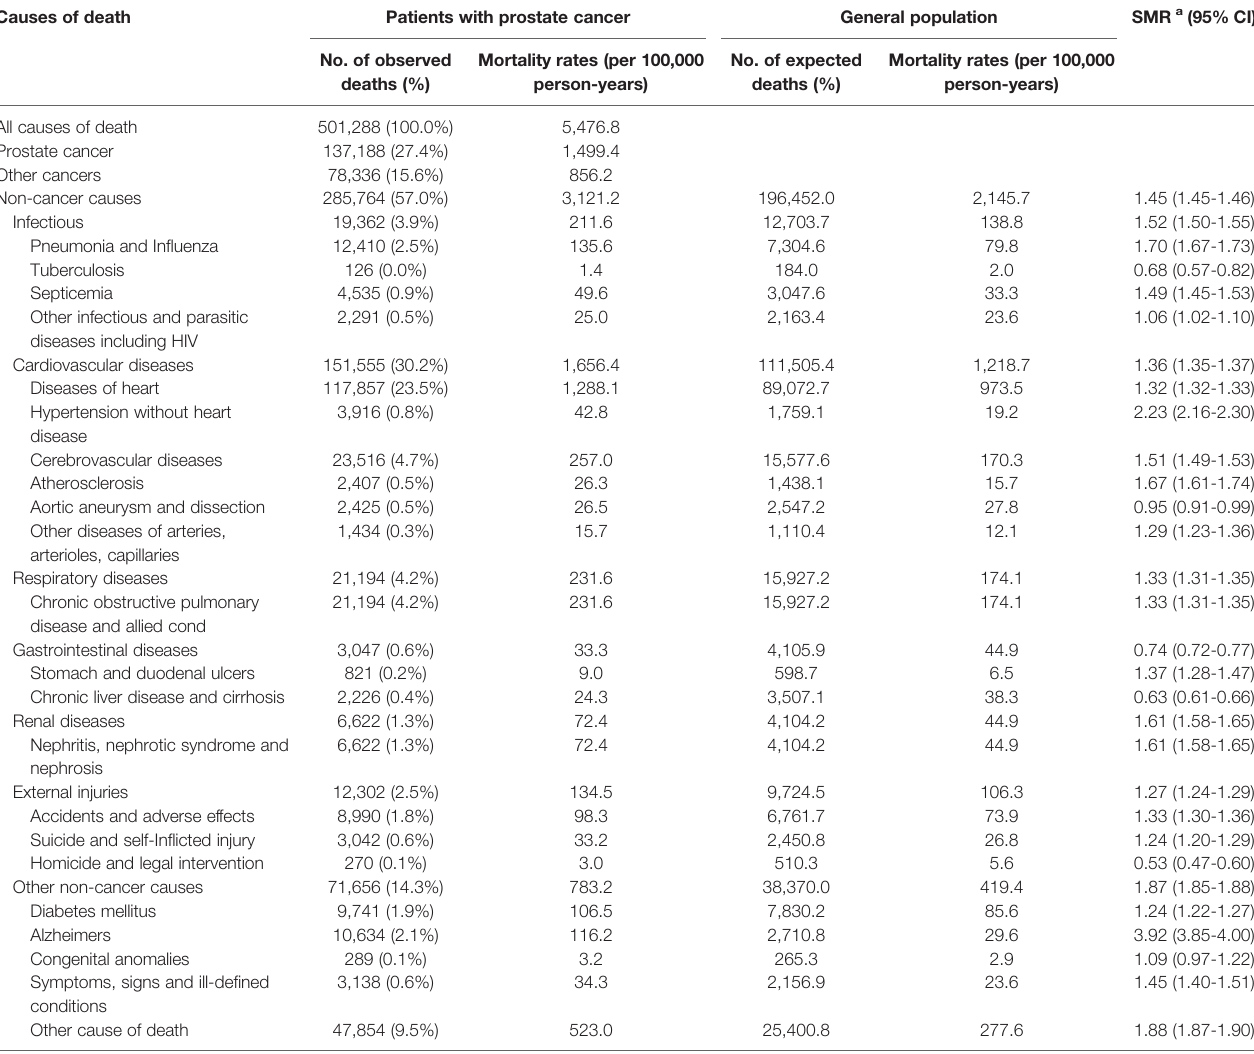
TABLE 2 | Cause of death for patients diagnosed with prostate cancers between 1975 and 2016 in SEER 18 registries. Causes of death Patients with prostate